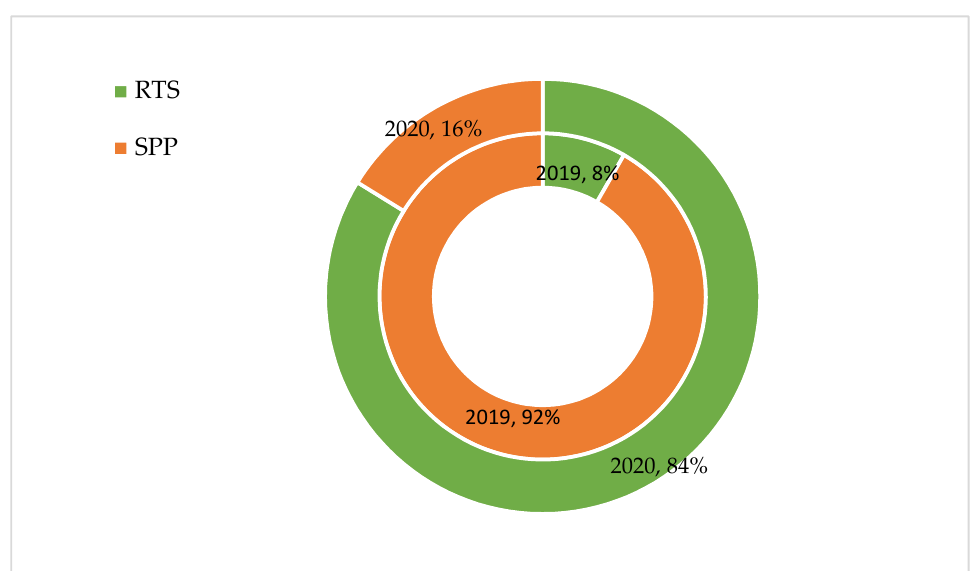
Figure 9. Share of total installed capacity of new SPP and RTS in 2019 and 2020. Reprinted with